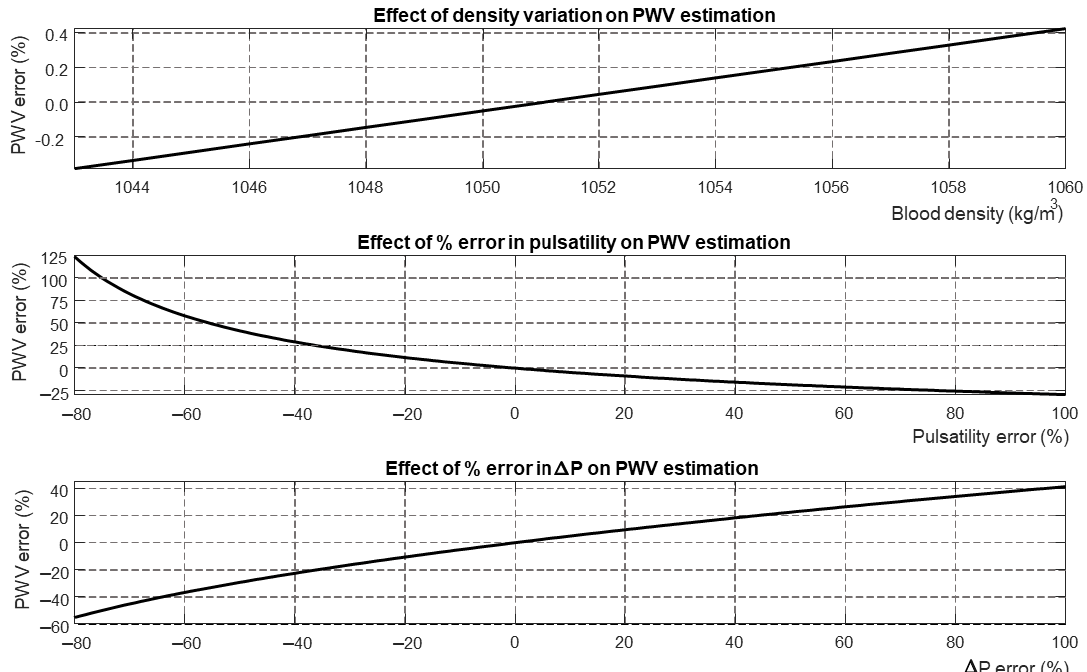
Figure 6. Sensitivity of PWV estimated by Bramwell–Hill equation to certain variables: blood density, error in measuring pulsatility, error in the estimation of pressure